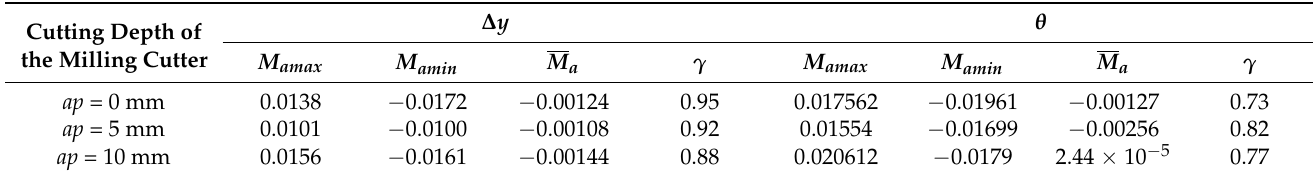
Table 8. The consistency of machining error distribution of surface positional error in the old